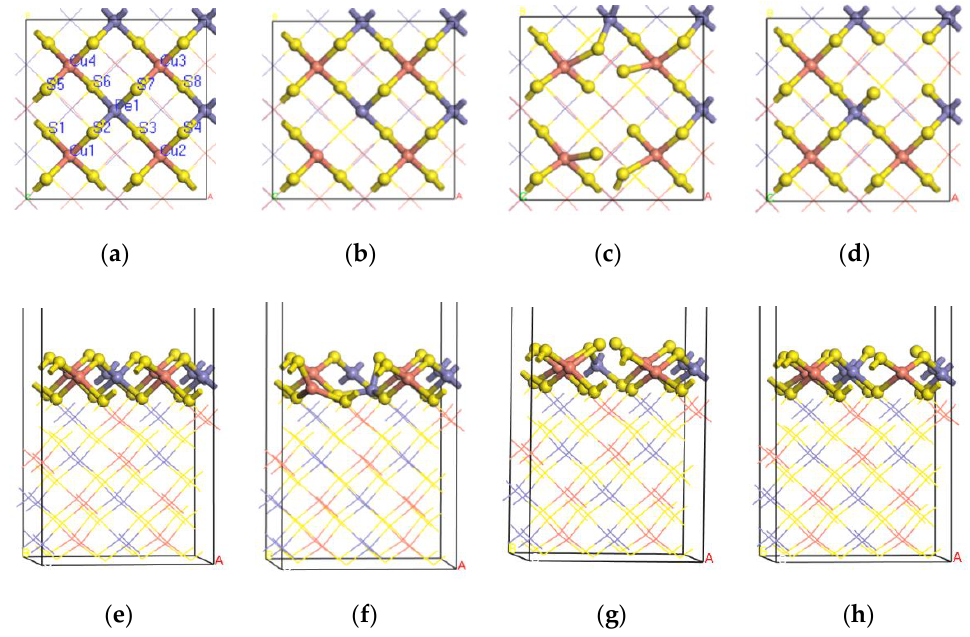
Figure 6. Optimized perfect chalcopyrite (0 0 1) surface, top views ( a ), side views ( e ); S-defect chalcopyrite (0 0 1) surface, top views ( b ), side views ( f ); Fe-defect chalcopyrite (0 0 1) surface, top views ( c ), side views ( g ); Cu-defect chalcopyrite (0 0 1) surface, top views ( d ), side views ( h ). Table 3. Surface charge comparison.